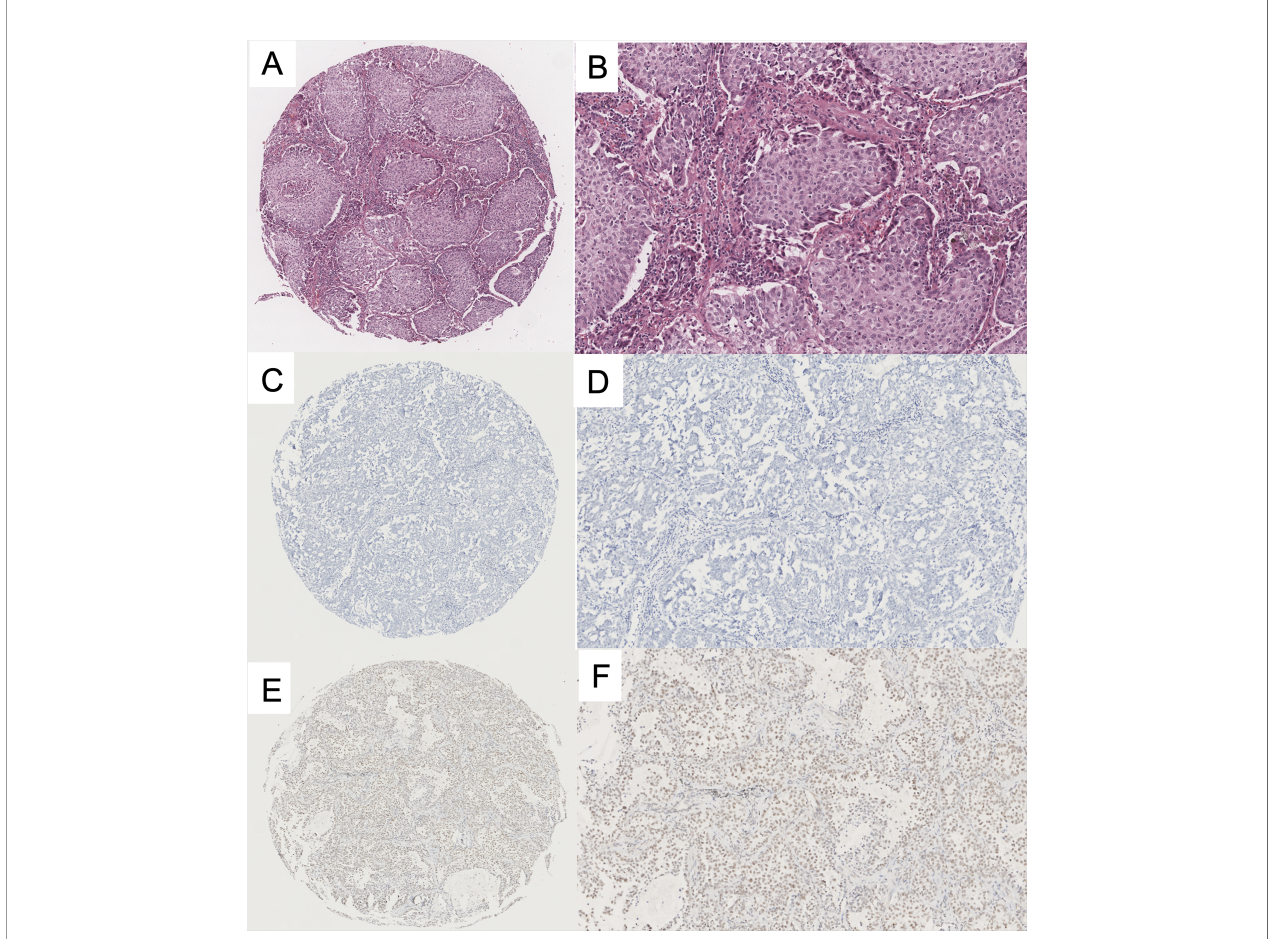
FIGURE 4 | Representative immunohistochemical (IHC) staining of heterogeneous nuclear ribonucleoprotein C (HNRNPC) protein in lung adenocarcinoma (LUAD) TMA. (A, B) H&E staining of LUAD tissue. (C, D) Negative immunohistochemical staining of HNRNPC in LUAD. (E, F) Positive immunohistochemical staining of HNRNPC in LUAD. The three images on the left are low-power fi elds, those on the right are high-power fi elds. TMA, tissue microarray; H&E, Hematoxylin and Eosin.